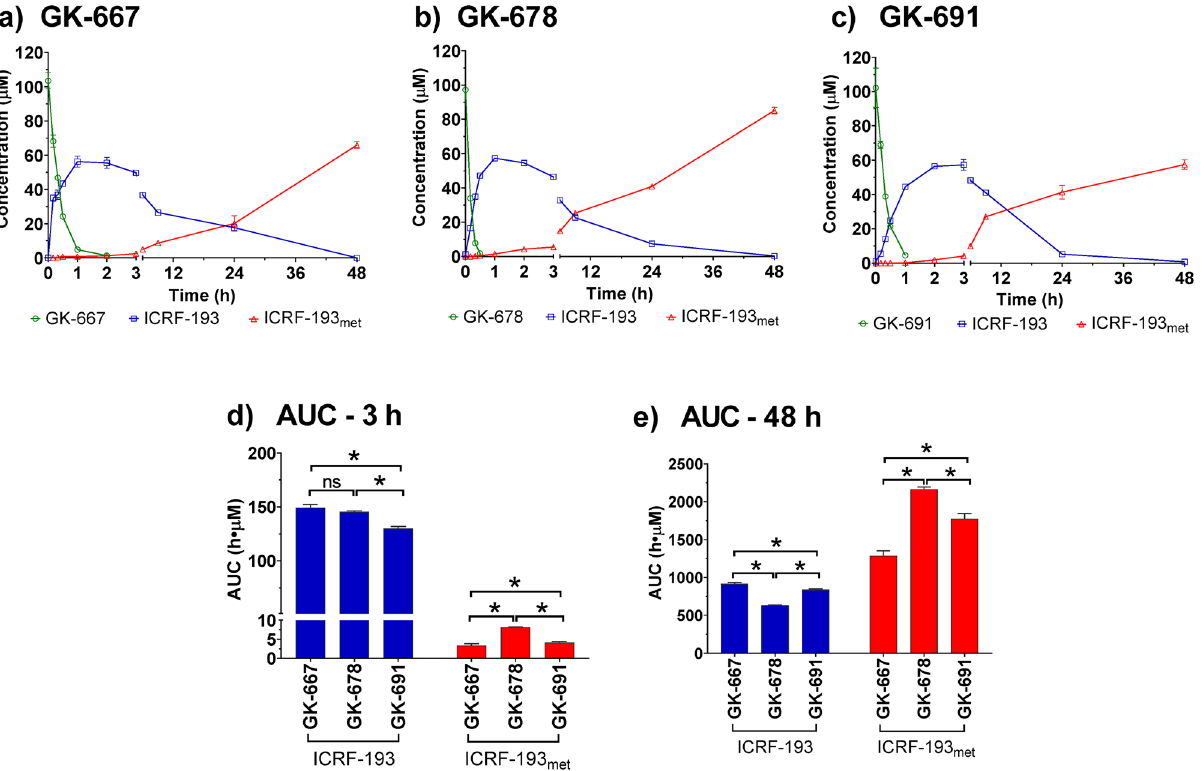
Figure 2. Activation of the prodrugs in cell medium—DMEM. Concentration time profiles of the prodrugs, ICRF-193 and ICRF-193 met obtained after incubation of ( a ) GK-667, ( b ) GK-678 and ( c ) GK-691 in DMEM (100 µM, 37 °C). Comparison of areas under the curve (AUC) of ICRF-193 and ICRF-193 met assayed at ( d ) 3 h and ( e ) 48 h of the prodrugs incubation in DMEM (100 µM, 37 °C). Data are presented as mean +/− SD (n = 4). Statistical significance was evaluated using one-way ANOVA and Holm-Sidak’s post-hoc test ( P ≤